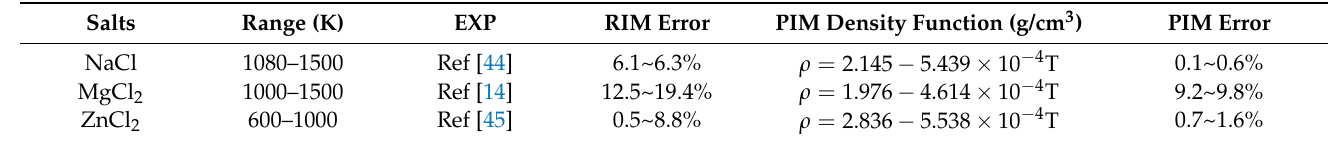
Table 6. Densities of molten chloride salts in experiment and simulation.